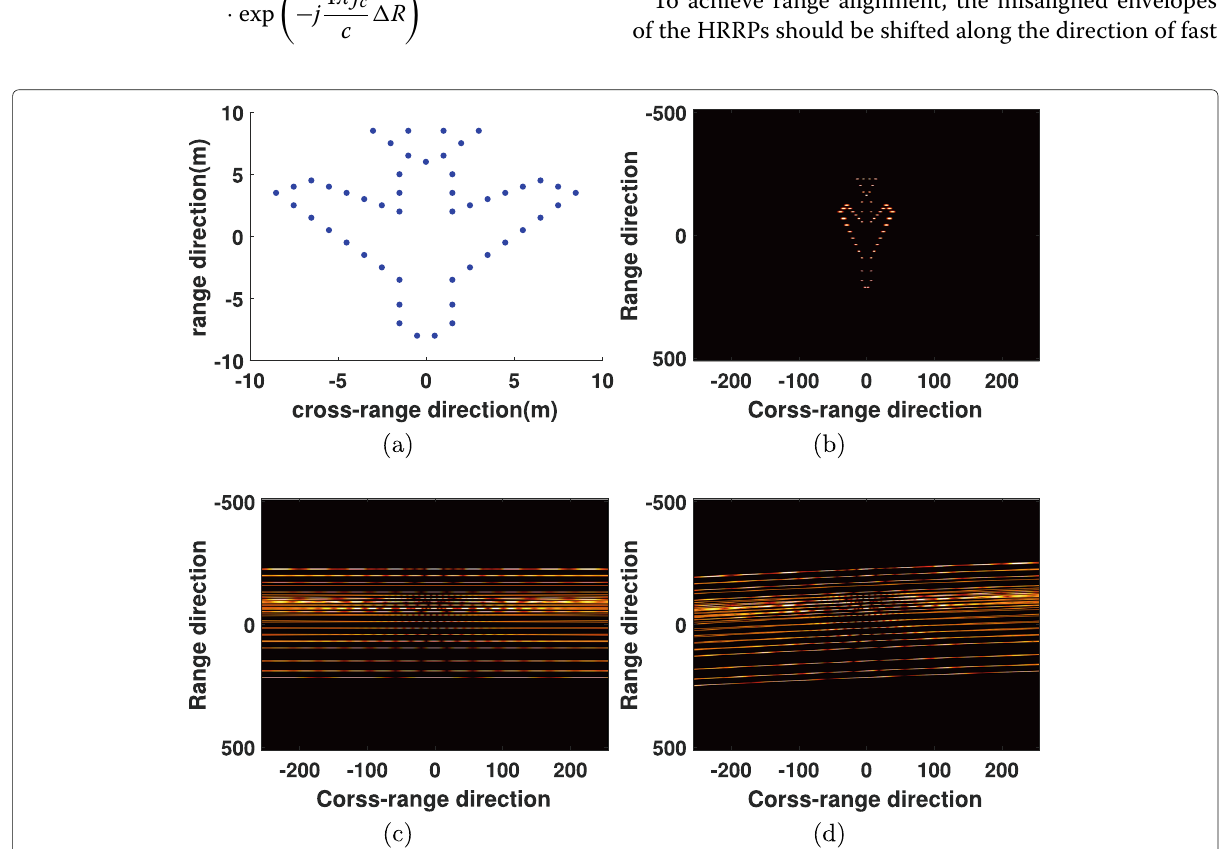
Fig. 3 The plane model. a The simulated plane model, b the original ISAR image, c the original range profiles, and d the contaminated range